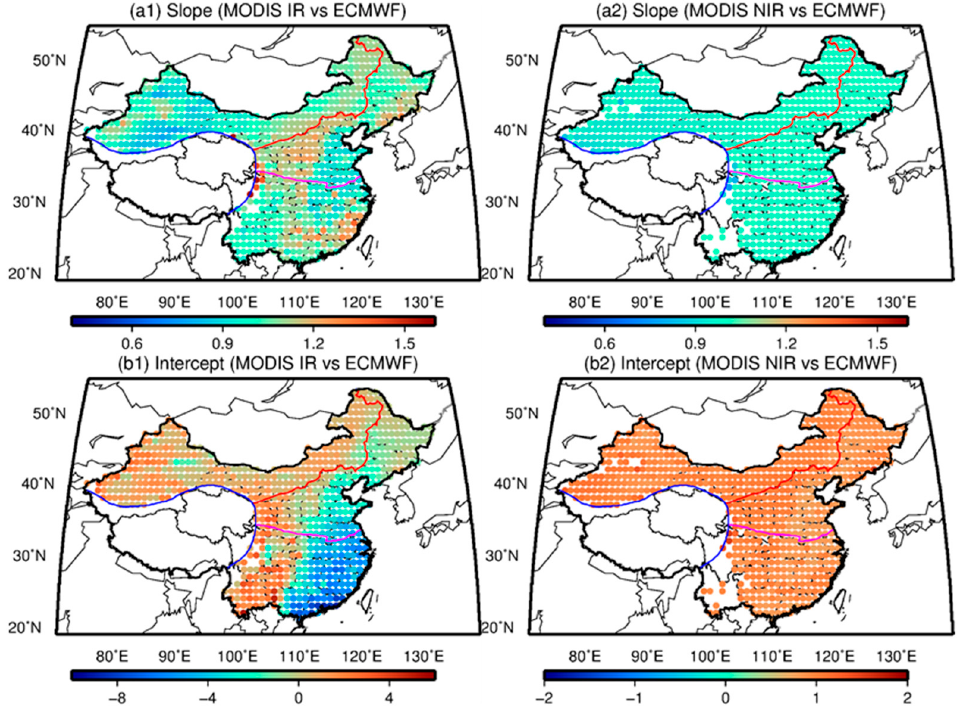
Figure 12. Distributions of slope and intercept of the linear model established to calibrate the MODIS PWV products using ECMWF ERA-Interim PWV data, where the first row ( a1 , a2 ) is the distribution of slope, and the second row ( b1 , b2 ) refers to the distribution of intercept.